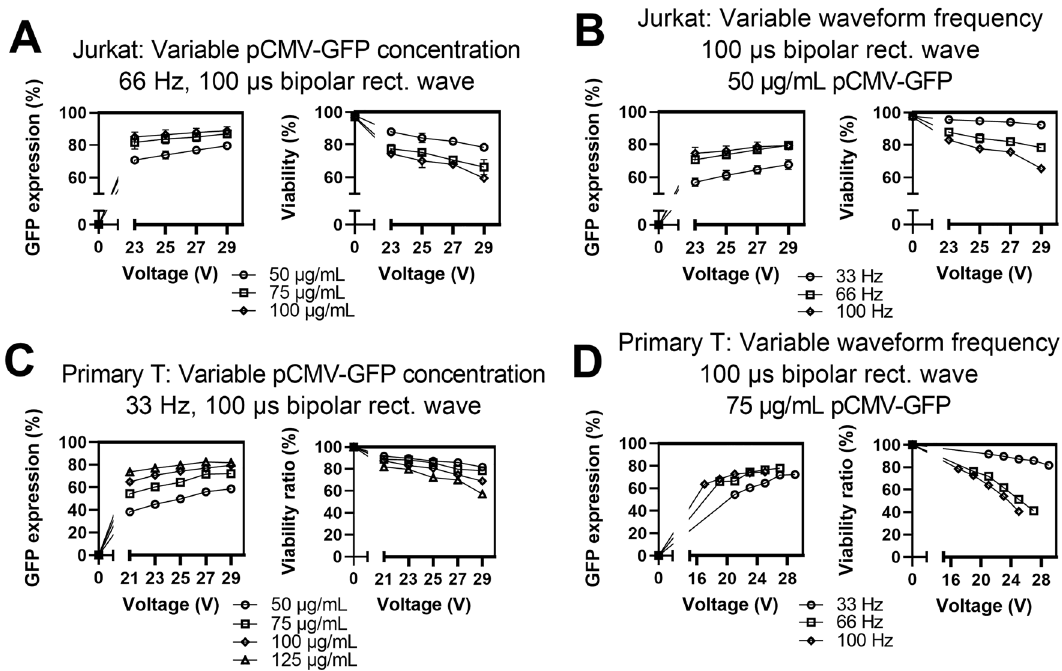
Figure 5. Results for various transfection parameters for delivering plasmid DNA encoding GFP to Jurkat and primary T cells. ( A ) Impact of varying plasmid concentration or ( B ) waveform frequency for delivering plasmid DNA to Jurkat cells. ( C ) Impact of varying plasmid concentration or ( D ) waveform frequency for delivering plasmid DNA to primary T cells. Data shown as mean ± standard deviation; n = 3 ( A , B ). Data shown as